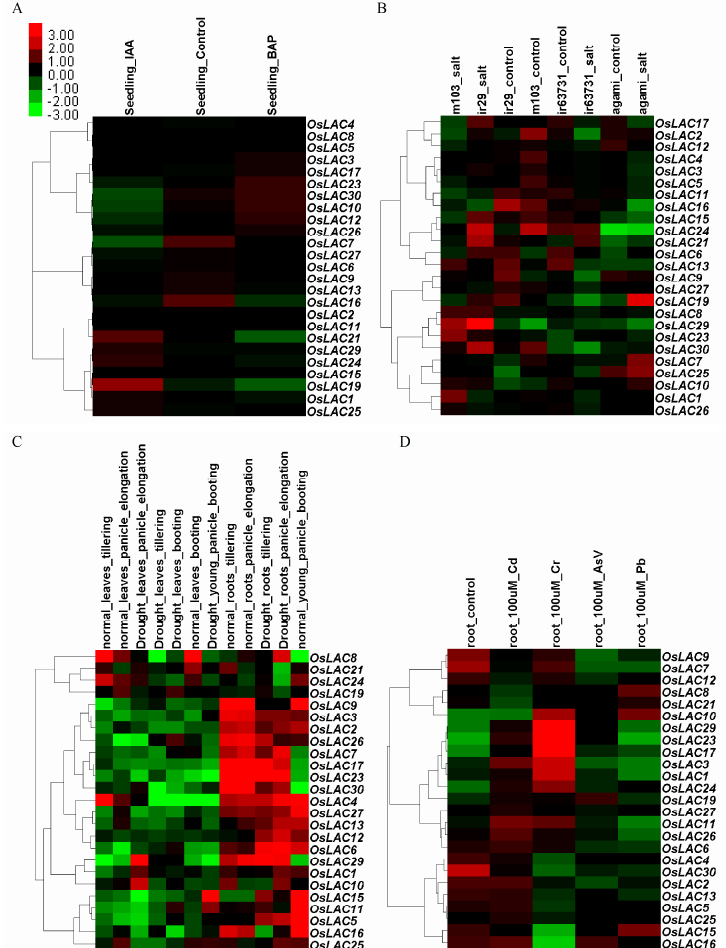
Figure 4. Clustering heat map of rice laccase genes expressions under hormones ( A ); salt ( B ); drought ( C ); and toxic heavy metals ( D ) treatments, Normalized Signal Intensity of genes obtained from Rice Oligonucleotide Array Database. Indica rice seedlings of ir64 variety were used for analysis of rice laccase genes expressions under hormones, drought and toxic heavy metals treatments; a salt-sensitive japonica rice m103, salt-tolerant japonica rice agami, salt-sensitive indica rice ir29 and salt-tolerant indica rice ir63731 were used for analysis of rice laccase genes expressions under salt treatment.